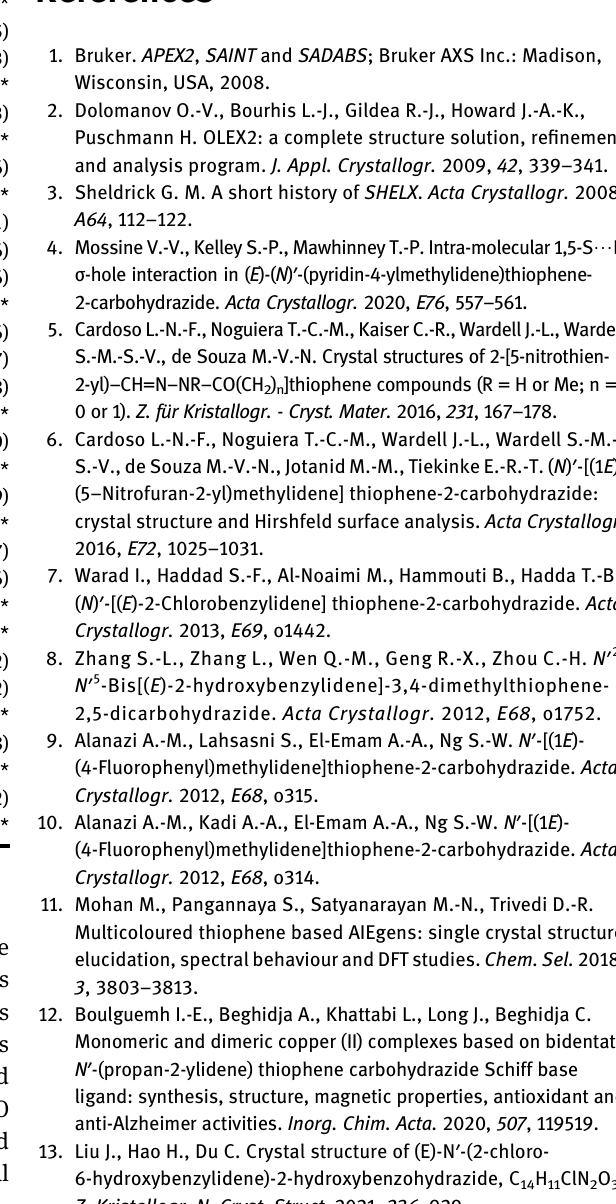
rings is 12.154(1) ° in the major component. Due to the consequence of repulsion between the nitrogen lone pairs and the adjacent N bonds, the angle of C6=N2 – N1 is 116.7(2) ° . Geometric parameters are in the expected ranges [6 – 10, 13]. In the crystal packing, the molecules are linked into one-dimensional chains along the b -axis by O – H / O hydrogen bonds. In addition, intramolecular O – H / N and N – H / O hydrogen bonds further consolidate the crystal structure.